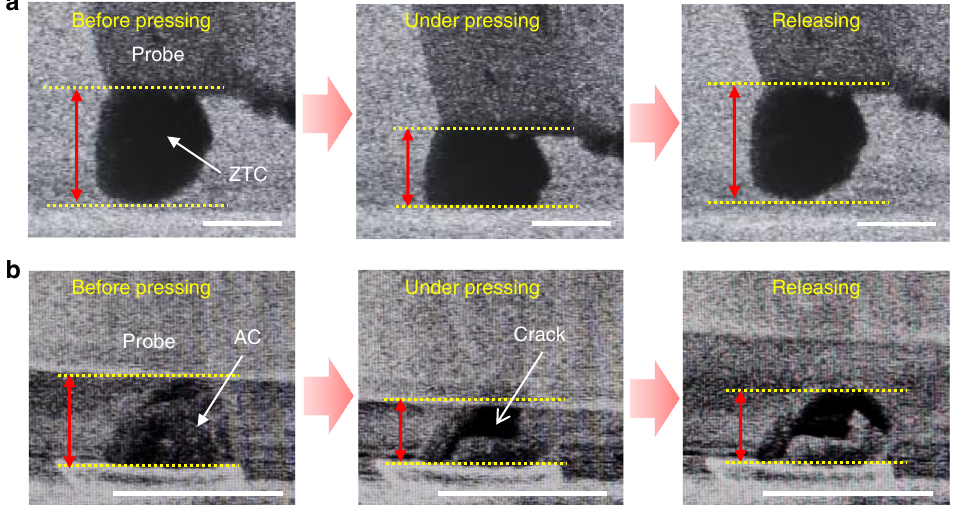
Fig. 3 In situ SEM images upon compression of a sample particle. a ZTC. b AC. Left, middle, and right images depict before pressing, during pressing with a tungsten probe and after releasing the force, respectively. In each image, yellow dotted lines indicate the positions of the top and the bottom of the sample particle. Red arrows show the height of the sample particle. Scale bars are 1 μ m. The corresponding movies are provided as Supplementary Movies 1 and